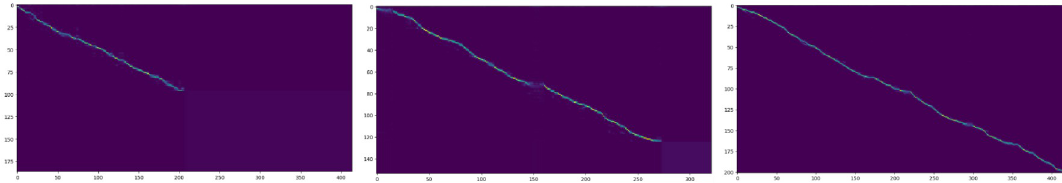
Fig 5. Smooth curve change graph during